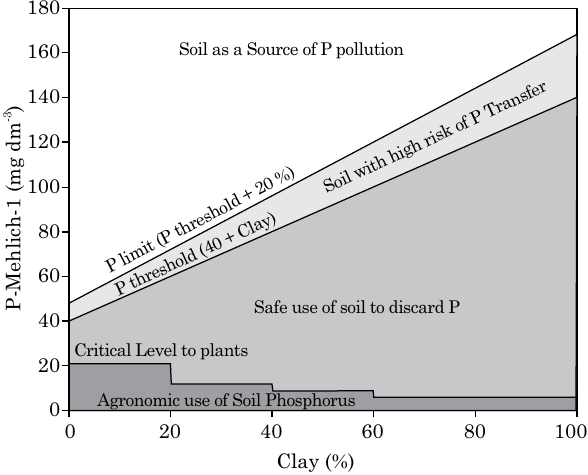
figure 7. Phosphorus critical levels, assessed by extraction with mehlich-1, depending on the soil clay content, according to the local Soil fertility committee (CQFS-RS/SC, 2004), with the P-threshold calculated using the P-threshold = 40 + Clay